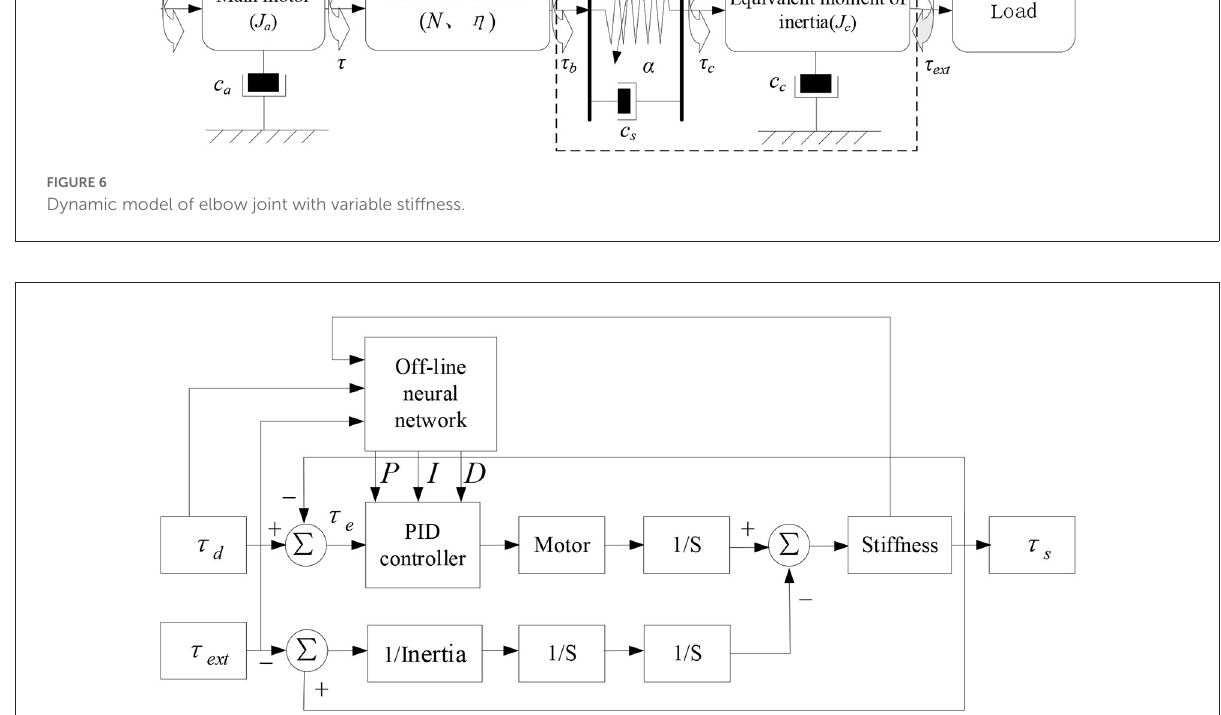
FIGURE7 PID control model based on BP neural